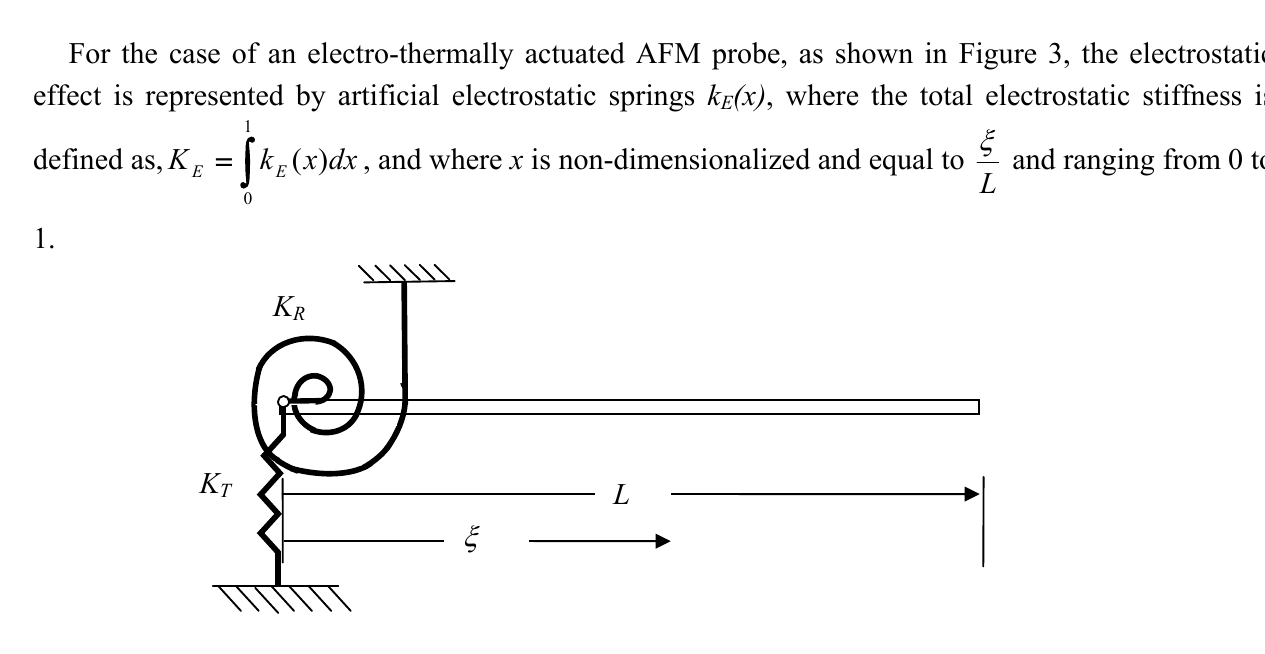
Figure 2. The non-classical boundary support model ed by artificial , and rotational K springs. translational, K T R